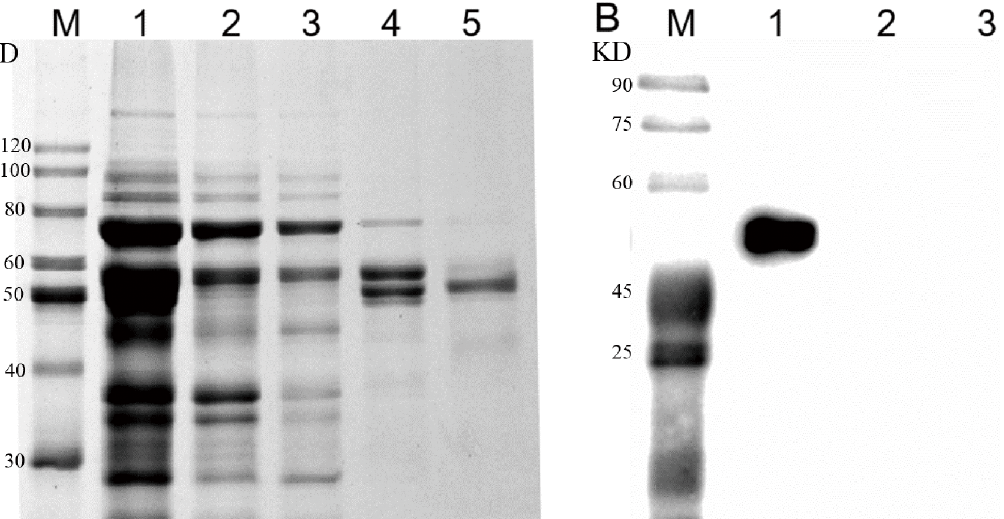
Fig 1. SDS-PAGE and Western blot analysis of Atm. A. SDS-PAGE analysis. M: Protein markers; Lane 1: cell extract; Lane 2: unbound proteins in the flow through from the column; Lane 3: the fraction from the wash buffer containing 40 mM imidazole; Lane 4: the fraction from the wash buffer containing 100 mM imidazole; Lane 5: the fraction from the elution buffer containing 500 mM imidazole. B. Western blot analysis. M: Protein markers; lane 1: protein extracts from pG-KJE8/BL21 with pCold I — atm; lane 2: protein extracts from pG-KJE8/BL21 with pCold I, as a negative control; lane 3, protein extracts from pG-KJE8/BL21, as an additional negative control.